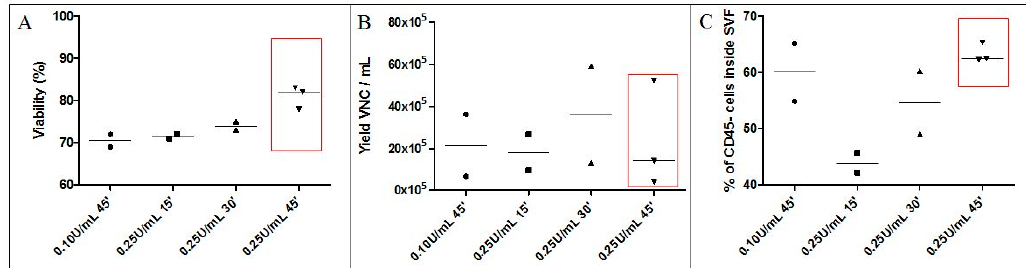
Figure 2. Assessment of several enzyme concentrations and digestion times for enzymatic digestion of AT. Final SVF products obtained with different conditions (0.10 U/mL and 45 min; 0.25 mL and 15 min; 0.25 U/mL and 30 min; and 0.25 U/mL and 45 min) were assessed in terms of ( A ) viability, ( B ) yield of VNCs per mL AT, and ( C ) cell subset distribution including the percentage of CD45 − regenerative cells. The red frame shows the chosen condition. Experiments were reproduced one to three times according to the available AT volume. SVF: stromal vascular fraction; VNC: viable nucleated cell; ’: minutes.